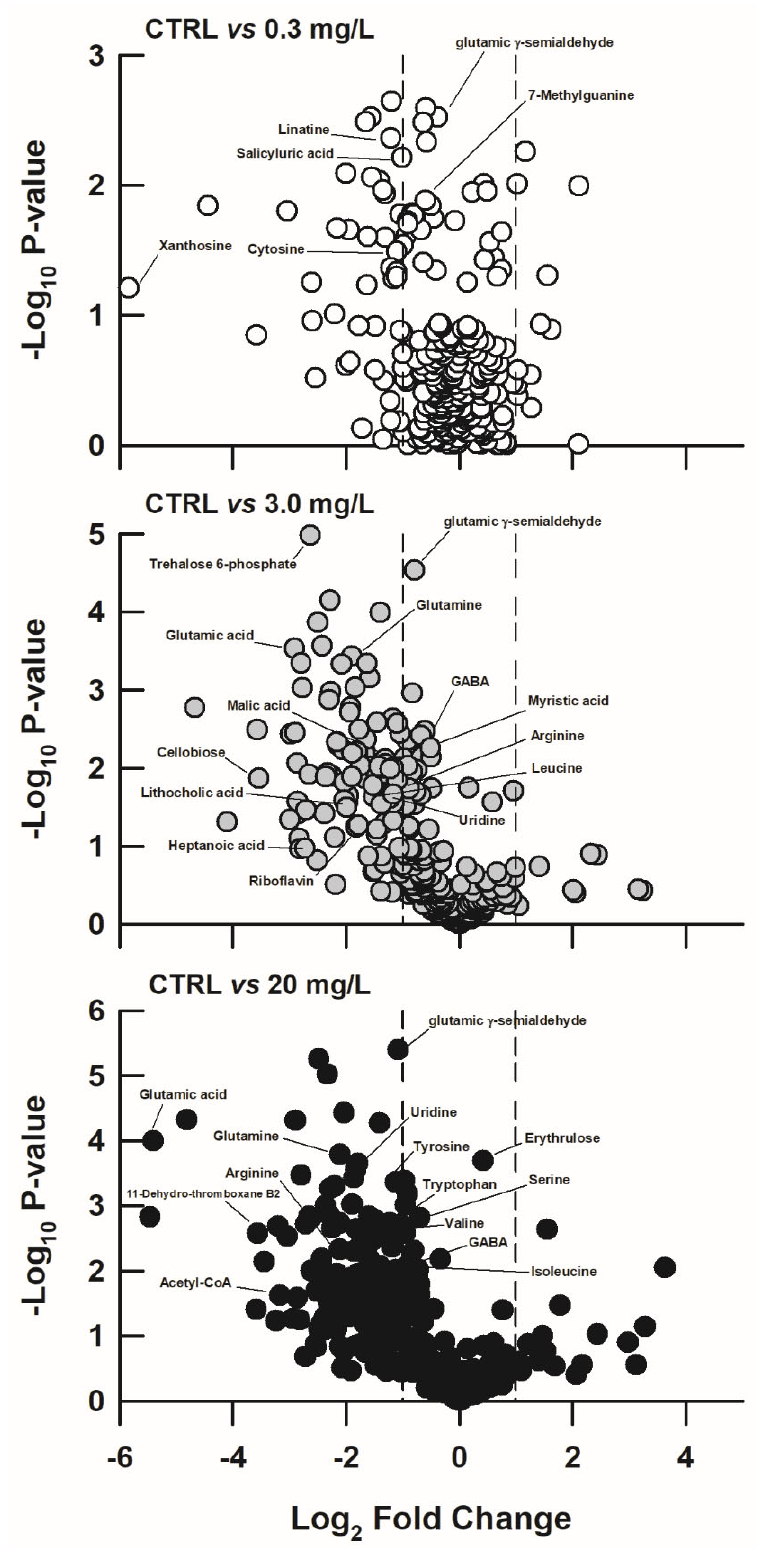
Figure 5. Volcano plots showing several differential hepatic metabolites between the CTRL and 0.3 mg/L, between the CTRL and 3.0 mg/L, and between the CTRL and 20 mg/L ammonia-exposed group of Trachemys scripta elegans juveniles.